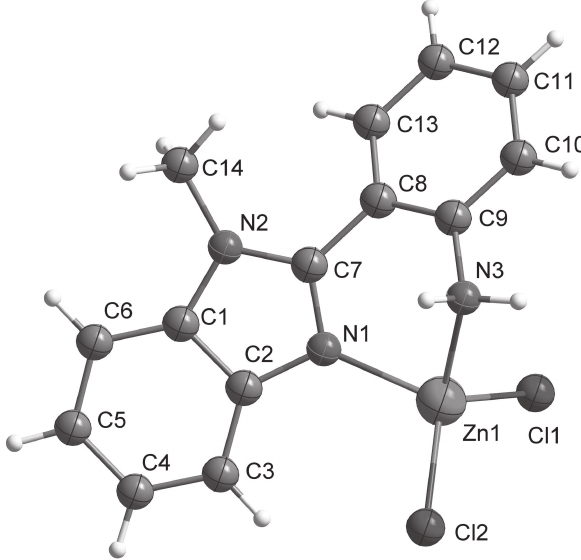
Table 1: Data collection and handling.